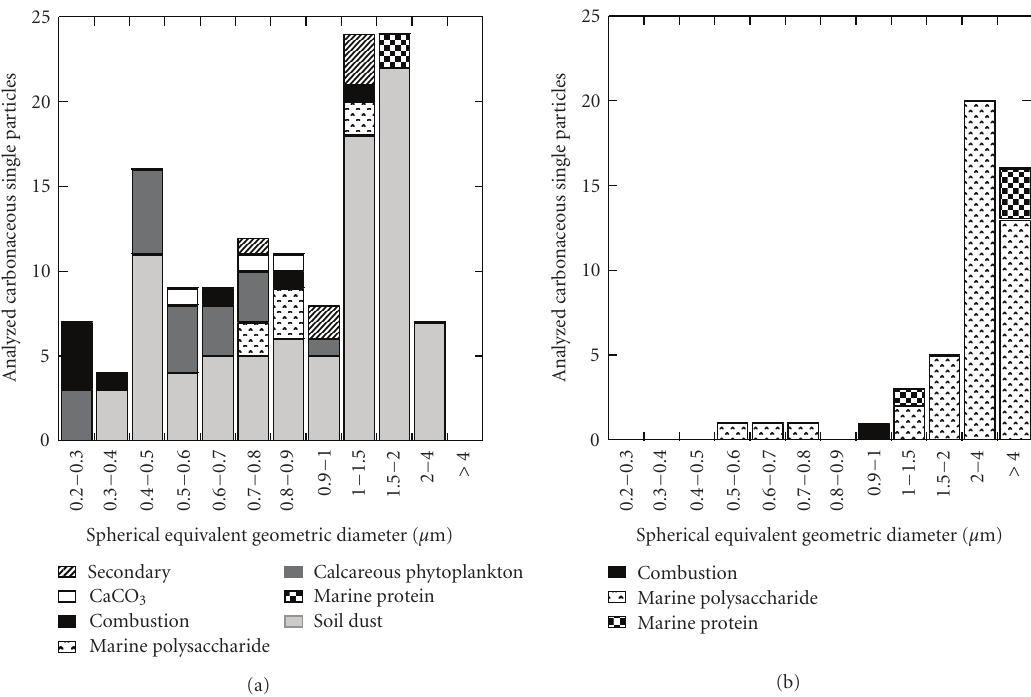
Figure 1: Distribution of the number of analyzed particles from (a) southeastern Pacific and (b) Arctic marine boundary layers. Particles labeled as “marine polysaccharide” in Arctic samples correspond to Figure 2(a) (PsI) while those in southeastern Pacific samples correspond to Figure 2(b) (PsII). Particle frequency for the collected samples is partly a result of sampling bias and does not represent the observed particle size